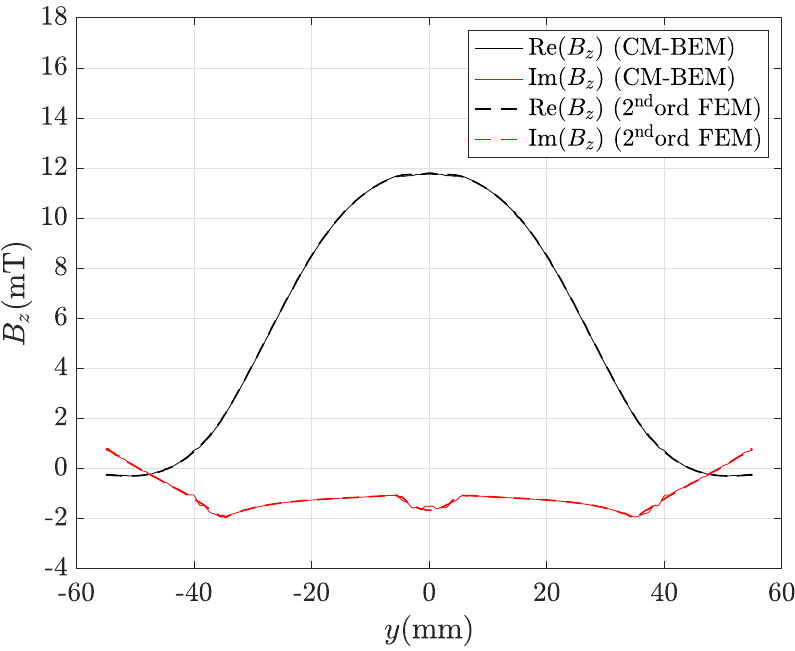
Figure 14. Real and imaginary parts of the z -axis magnetic flux density component at 50 Hz along the line A-B (CM–BEM plot is in straight line, FEM plot is in dashed line).